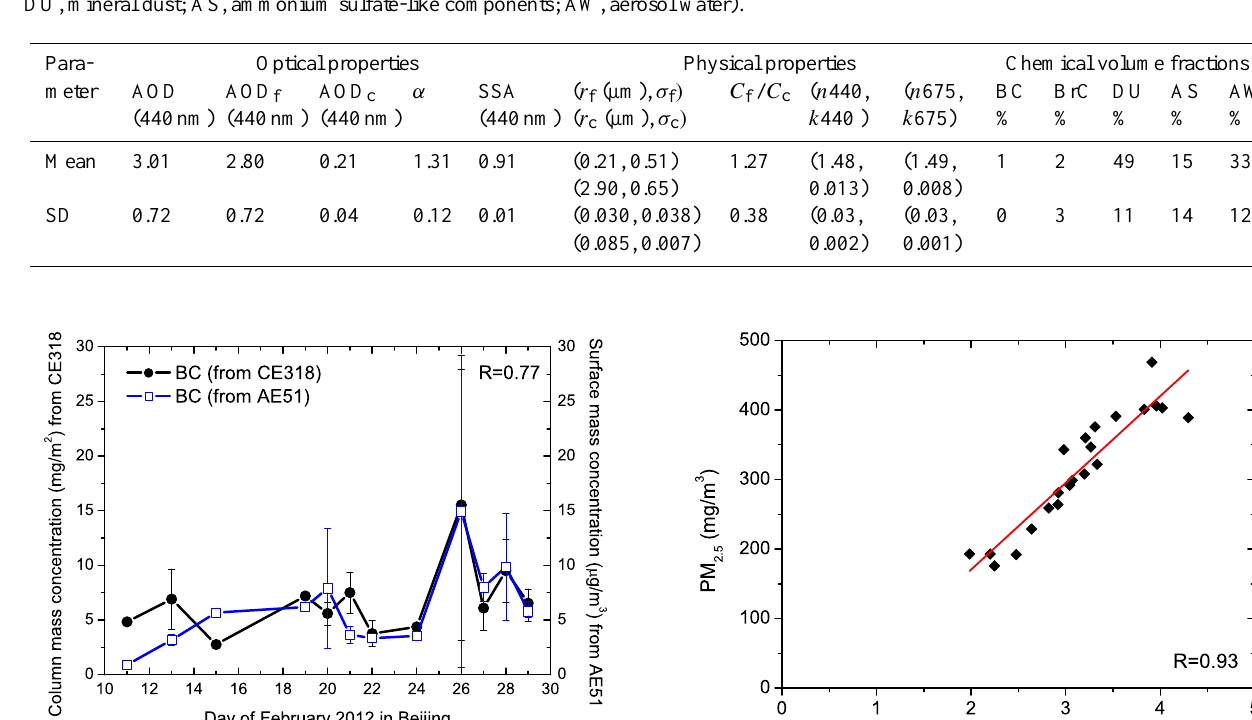
Table 2. Average heavy haze parameters derived from remote sensing measurements in Beijing winter. (AOD, aerosol optical depth; AOD f , fine-mode aerosol optical depth; AOD c , coarse-mode aerosol optical depth; α , Ångström exponent (440–870nm); SSA, single-scattering albedo; r f , median radius of fine-mode particles; σ f , standard deviation of fine mode; r c , median radius of coarse-mode particles; σ c , standard deviation of coarse mode; C f / C c , ratio of the fine- and coarse-particle volume concentration; n , real part of the refractive indices (at 440 and 675nm, respectively); k , imaginary part of the refractive indices (at 440 and 675nm, respectively); BC, black carbon; BrC, brown carbon; DU, mineral dust; AS, ammonium sulfate-like components; AW, aerosol water).